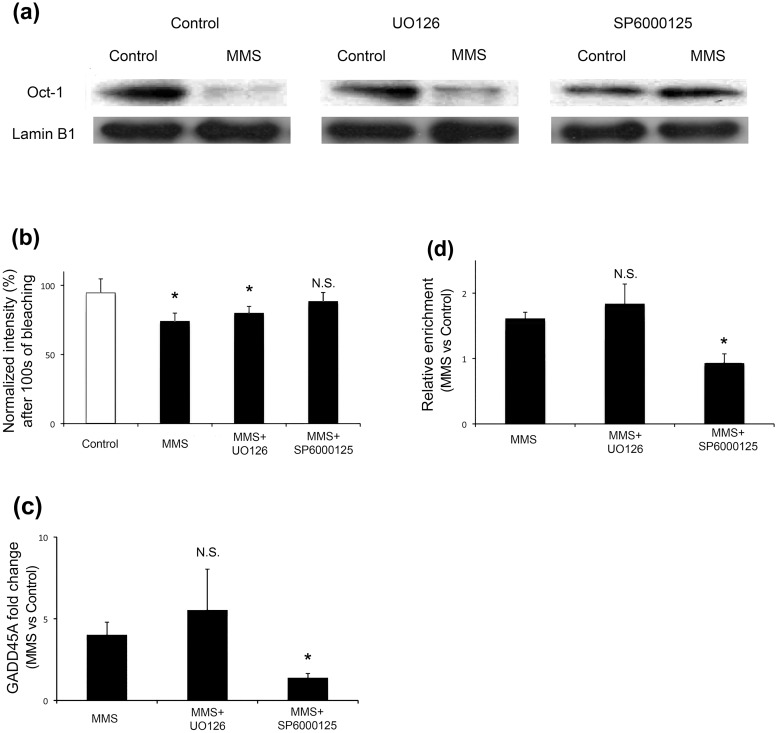
Loss of Oct-1 sequestration by lamin B1 in response to MMS is JNK dependent.(a) Co-immunoprecipitation of Oct1 with lamin B1: The lamin B1 Co-IP experiments shown in Fig 1 were repeated in HeLa cells that had been pre-treated with a JNK inhibitor (SP6000125) or ERK inhibitor (UO126) before control or MMS treatment. The JNK inhibitor reduces the MMS-dependent release of Oct-1 from lamin B1. (b) FLIP analysis of GFP-Oct-1 stability at the nuclear envelope: Normalised intensity measurements of regions of interest containing the peripheral GFP-Oct1 signal were used to assess fluorescence loss in photobleaching for control HeLa cells, or cells treated with MMS, with or without kinase inhibitor pretreatment. The graph displays the mean intensity value after multiple bleach cycles over 100 seconds, and confirms the effect of MMS shown in Fig 1 (section b). This weakened interaction effect is still seen after ERK inhibition, but is lost if JNK is inhibited. (c) MMS-induced GADD45A expression: GADD45A expression was assessed using qPCR in control and MMS treated HeLa cells that had received no pretreatment, or treatment with ERK or JNK inhibitors. The ratio of fold change in GADD45A transcript level for MMS over control is shown; only when JNK is inhibited is the MMS-induced elevation of GADD45A prevented. (d) Oct1 occupancy at GADD45A promoter site: The binding of Oct-1 to its target sequence within the promoter region of GADD45A was assessed using qPCR following Oct1 ChIP. The graph shows relative enrichment of Oct1 occupancy at the GADD45A promoter in MMS-treated versus control cells. Thus, a ratio >1 indicates higher occupancy after MMS treatment. Pretreatment with an ERK inhibitor had no effect, while inhibition of JNK abolished the MMS-induced increase in promoter site occupancy.